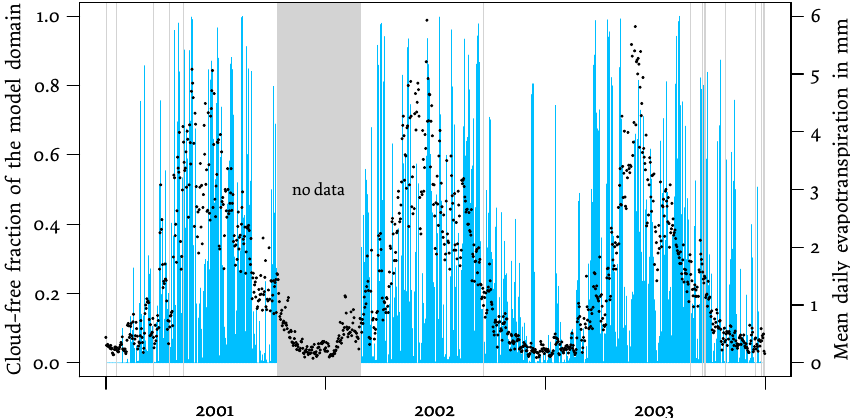
Fig. 6. Daily blue-sky fractions (light blue, left hand y axis) and average evapotranspiration rates (black dots, right hand y axis) of the modelled part of the Elbe River basin, average of 2001–2003. Cloud coverage was calculated from the available LST maps (grey colour indicates data gaps), and ET a values were obtained from the globally pre-calibrated SWIM model.